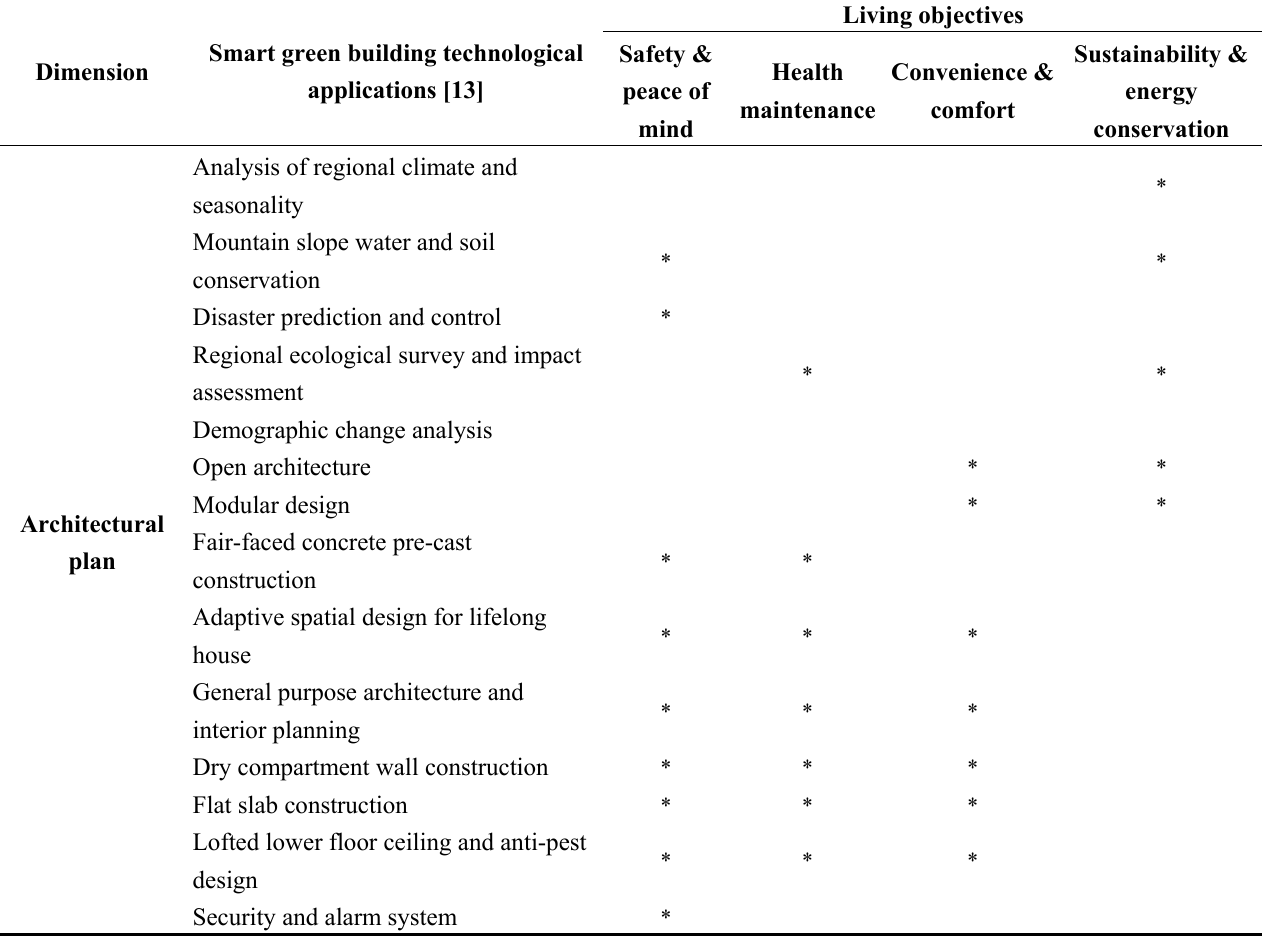
Table 2. The S House’s design, technological applications, and living objectives.